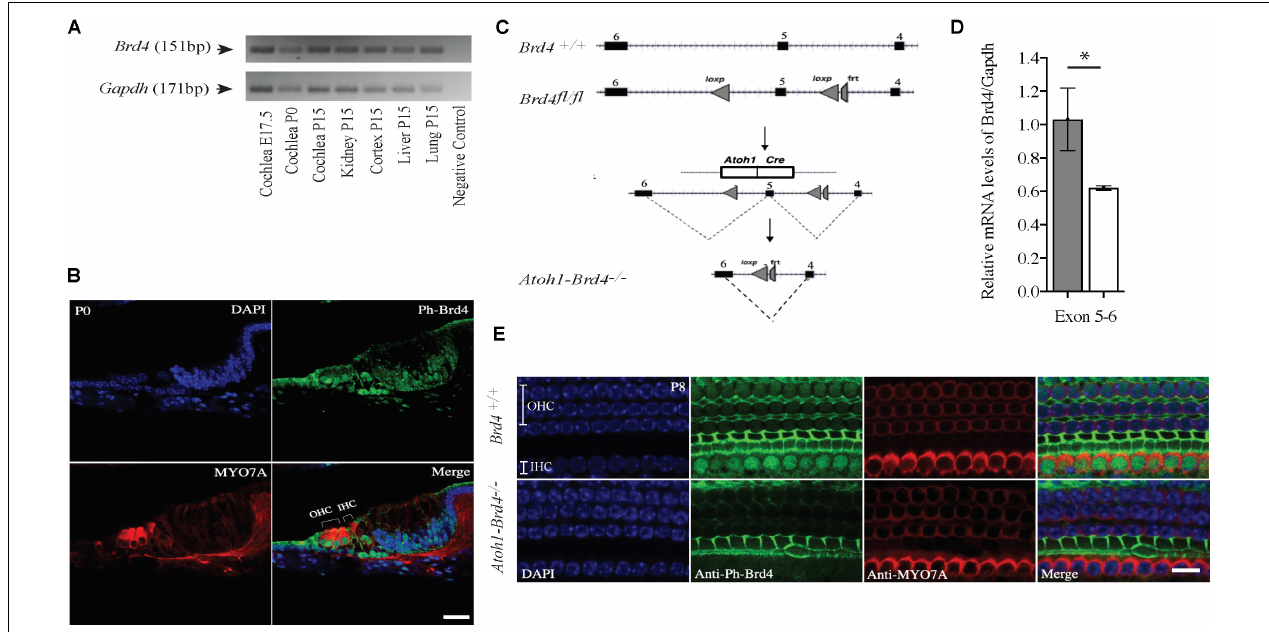
FIGURE 1 | Mouse Brd4 expression, generation, and confirmation of HC specific knockout. (A) Expression of mBrd4 (Exon 5-6) in the cochlea during the different developmental stages (E17.5 to P15) is observed relative to mGapdh . (B) Immunostaining of Brd4 + / + section ( n = 3) show Brd4 expression (green) in nucleus of every cell-type in the inner ear as indicated by its colocalization with DAPI (blue, nuclei), including hair cells, labeled with HC specific Myo7a (red) (Scale = 10 µ M). (C) Brd4 tm1c mice (referred to as Brd4 fl / fl ) were crossed with B6.Cg-Tg (Atoh1-cre) 1Bfri/J (The Jackson Laboratory Stock #011104) mice (referred to as Atoh1-cre), to obtain Atoh1-Brd4 − / − HC specific knockout and control littermates. (D) qRT-PCR results showed that mBrd4 (Exon 5-6) levels were decreased significantly in (white) Atoh1-Brd4 − / − compared to (gray) Brd4 + / + samples (triplicates of each n = 3, Brd4 + / + and n = 4, Atoh1-Brd4 − / − samples). (E) Z-stack of P8 ( n = 3) cochlea immunostained with Brd4 (green), the HC marker Myosin7a (red) and DAPI (blue, nuclei). Results showed Brd4 was absent in the IHCs and OHCs of the Atoh1-Brd4 − / − mice (Scale = 10 µ M). (Standard T -test was performed to determine the significance of the experiment, ∗ p < 0.05, ∗∗ p < 0.01, ∗∗∗ p < 0.001, ns-not